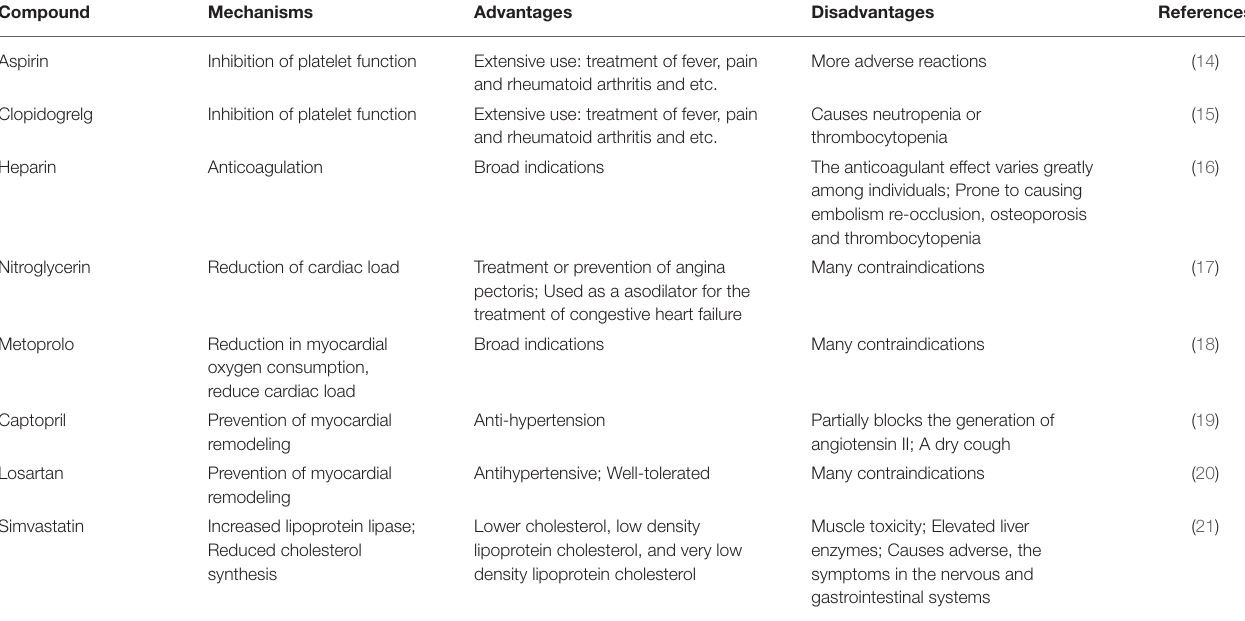
TABLE 1 | The main traditional Western medicine used for myocardial ischemic